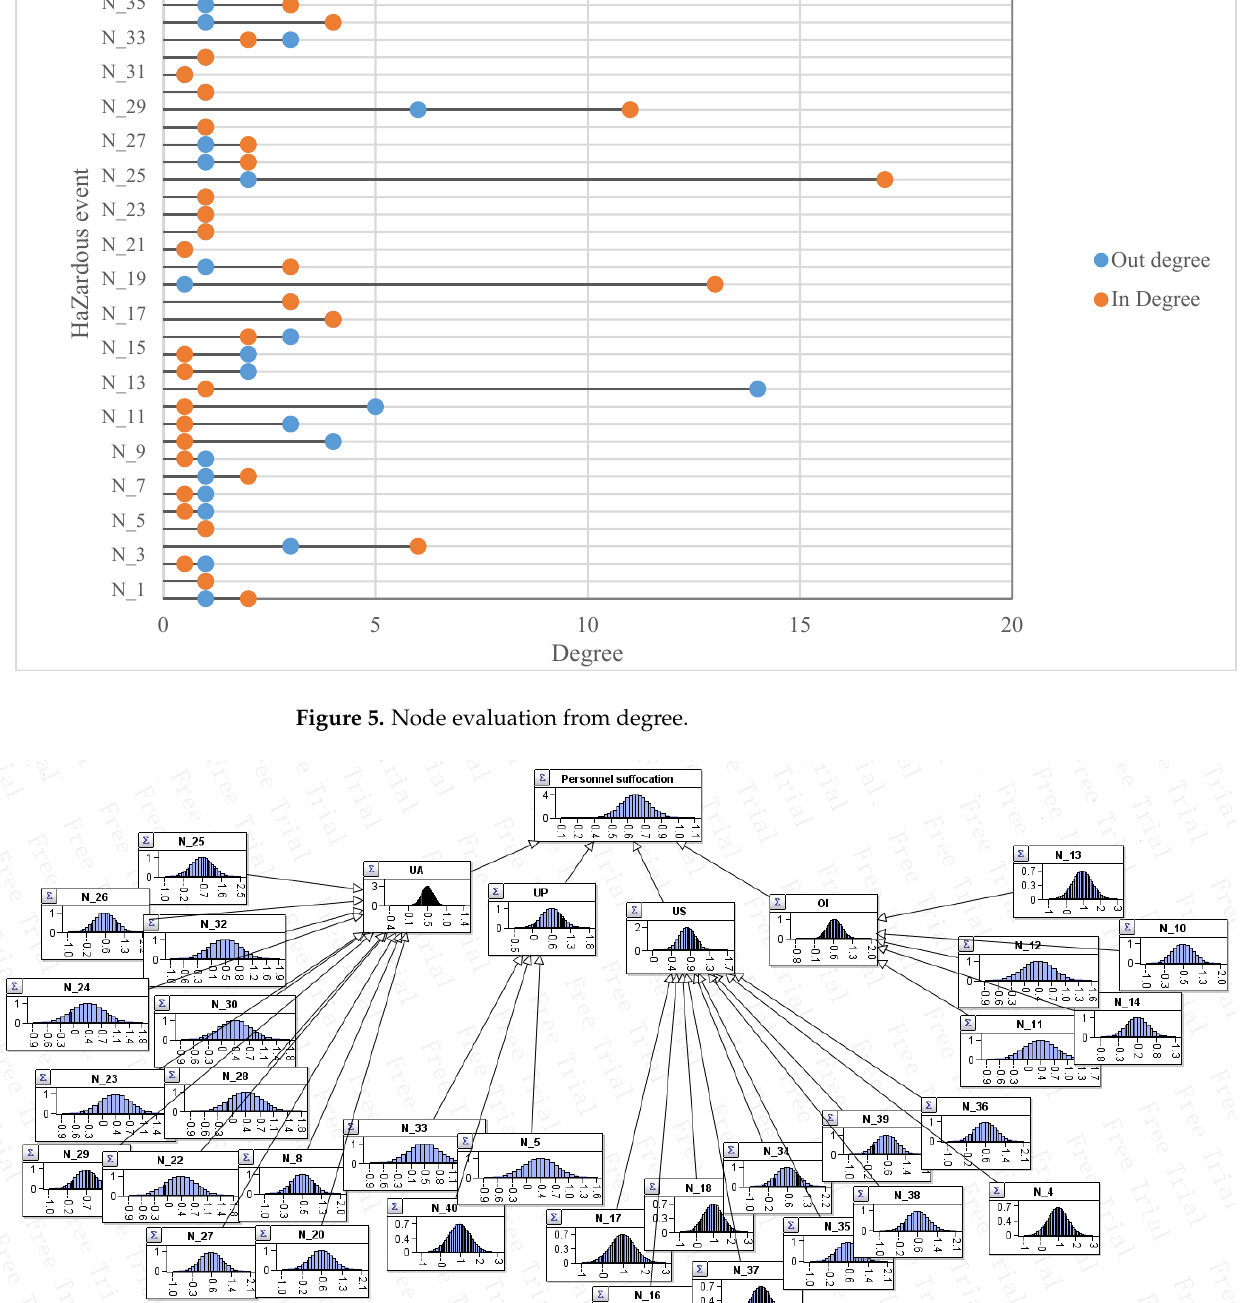
Figure 5. Node evaluation from degree.